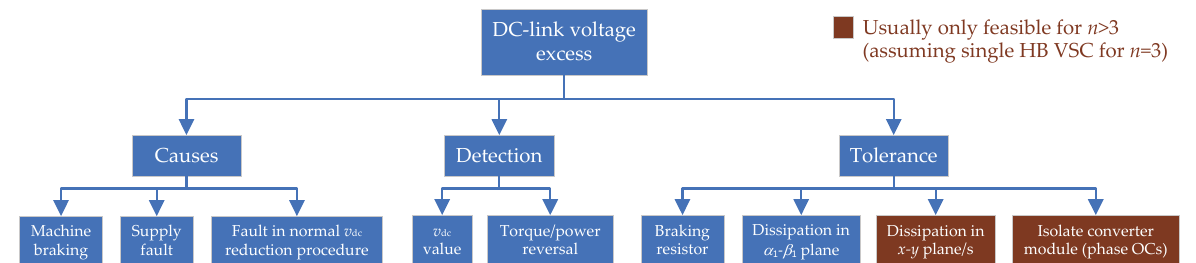
Figure 36. Causes, detection methods and tolerance approaches for dc-link voltage excess in multi- phase